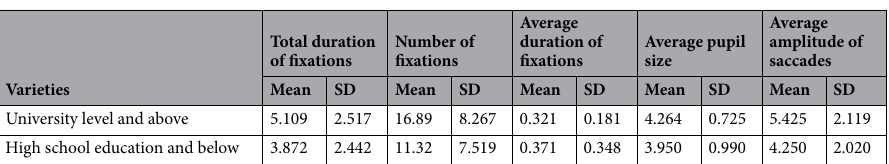
Table 8. ANOVA results of eye movement indexes of different educational background. Precision (SD) = standard deviation of data samples.